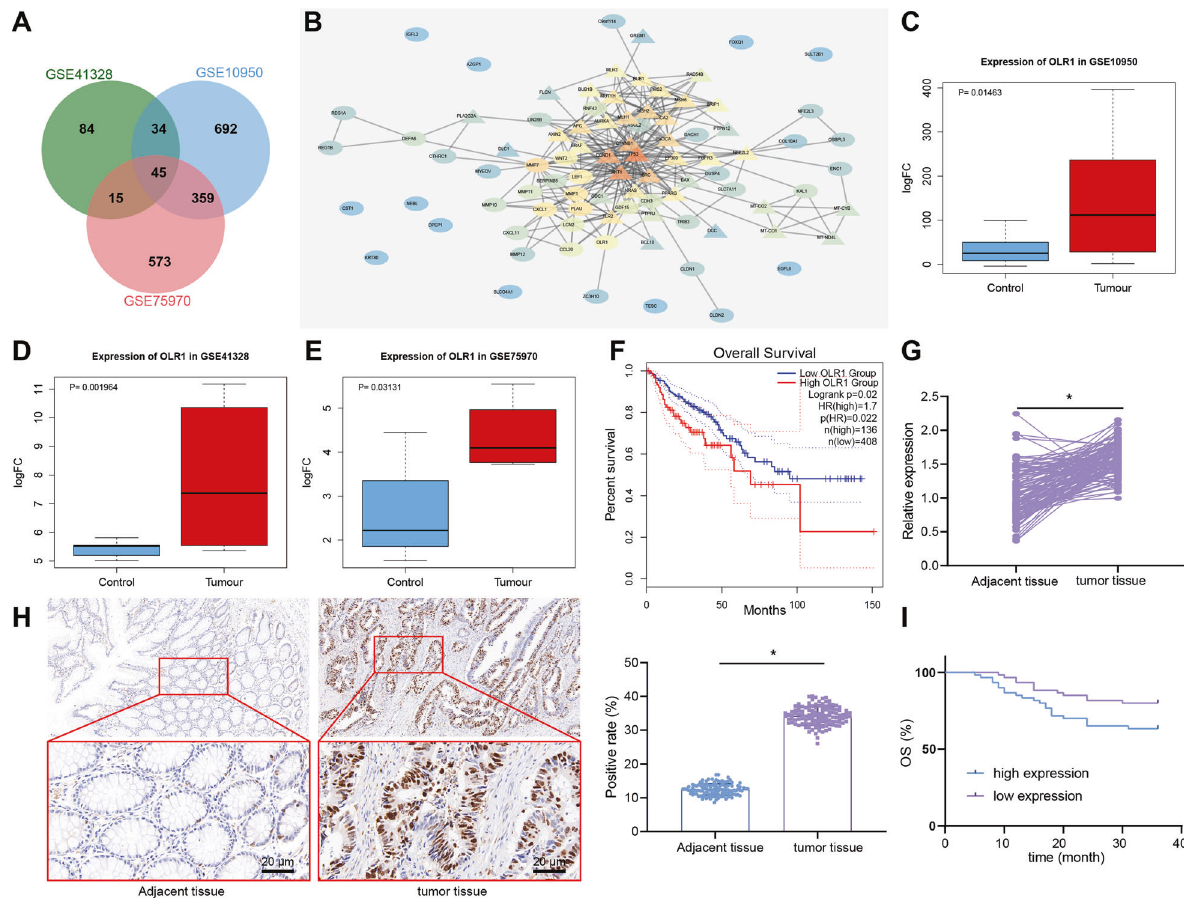
Fig. 1 OLR1 expression is high in colon cancer tissues. A Venn map of upregulated genes in GSE10950, GSE41328, and GSE75970, which obtained 45 overlapping genes. B Protein interaction network of 45 overlapping genes and 50 important genes of colon cancer from MalaCards. Circles represented intersecting genes and triangles represented genes obtained by MalaCards. The redder the color of the gene image, the higher the degree of core. Conversely, the bluer the color, the lower the degree of core. C The box diagram of the expression of OLR1 in GSE10950 (control n = 24; tumor n = 24). D The box diagram of the expression of OLR1 in GSE41328 (control n = 24; tumor n = 24). E The box diagram of the expression of OLR1 in GSE75970 (control n = 24; tumor n = 24). The blue box indicated the expression of normal samples, and the red box indicated the expression of tumor samples. F GEPIA to analyze TCGA clinical data to draw the curve between OLR1 expression and colon cancer survival. G RT-qPCR to detect the expression of OLR1 mRNA in colon cancer tissues and adjacent normal tissues (adjacent tissues: n = 120; tumor tissues: n = 120). H The expression of LOX-1 protein in colon cancer tissues and adjacent normal tissues detected by immunohistochemistry (adjacent tissues: n = 120; tumor tissues: n = 120; ×500). I Kaplan-Meier curve of the relationship between OLR1 and survival in patients with colon cancer. * p < 0.05 between two